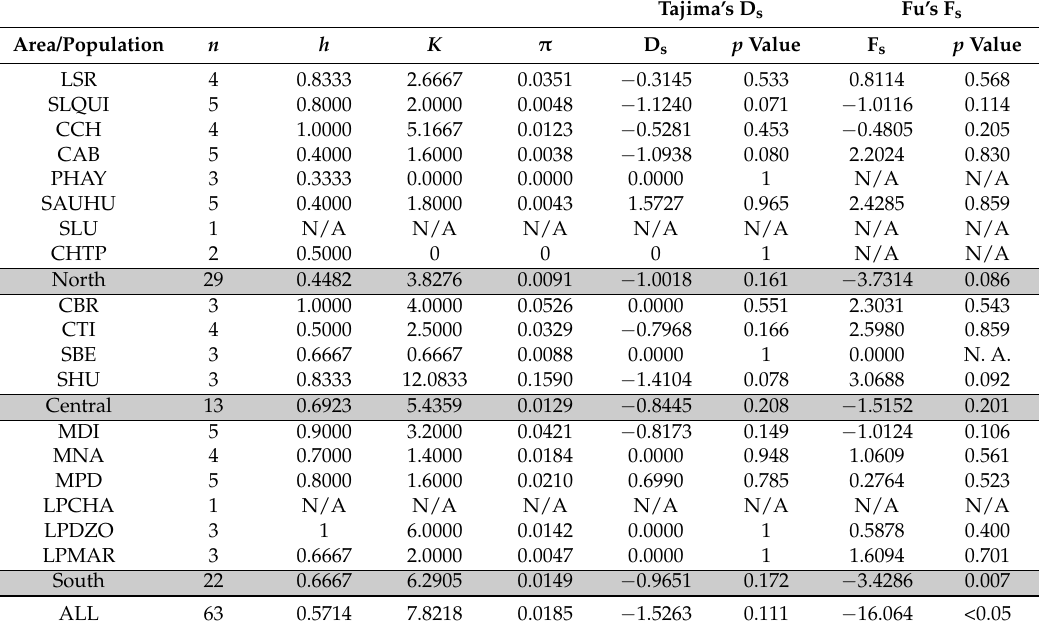
Table 4. Genetic diversity and Neutrality tests (Tajima’s D s and Fu’s F s ) per H. hydnorae locality and per SAMOVA defined locality group. ( n : number of individuals per locality; h : haplotype diversity; π : nucleotide diversity; K : average number of pairwise